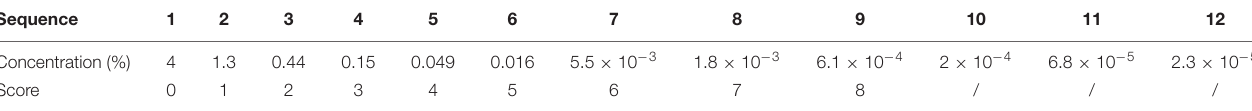
TABLE 1 | CCCRC test series dilution and ODT scoring